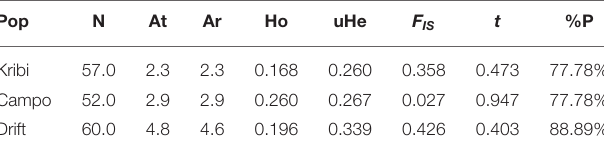
TABLE 1 | Genetic diversity measures show higher genetic diversity in the drift propagule pool (Drift) compared to nearest mangrove forest areas. Pop N At Ar Ho uHe F